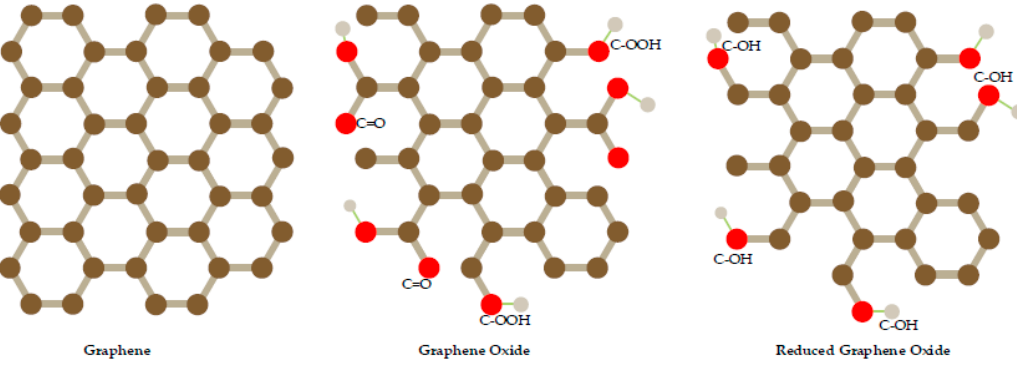
Figure 4. Structure of graphene, graphene oxide, and reduced graphene oxide. Reprinted with permission from [29].